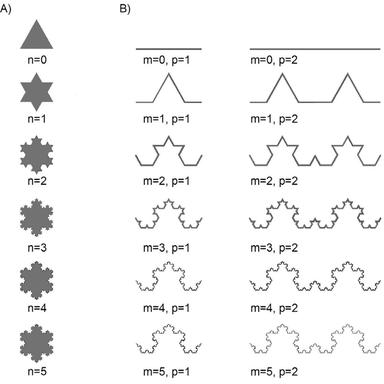
Fractal algorithm based on the Koch curve and three complexity parameters n, m and p to generate the cross-section (A) and the longitudinal profile (B) of reinforcing elements with fractal geometry.